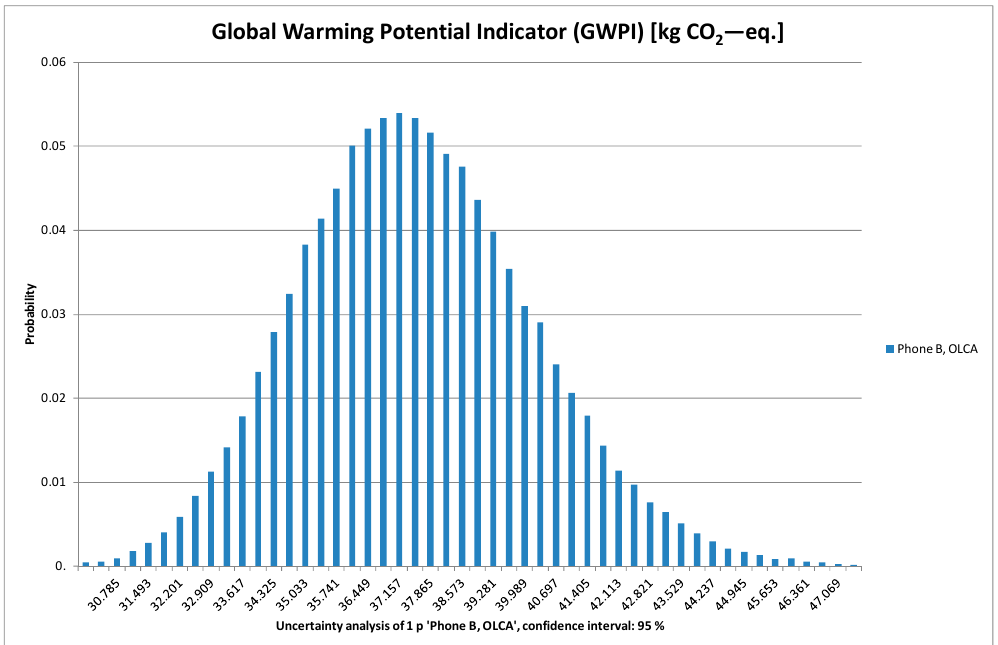
Uncertainty analysis of 1 p 'Phone B, OLCA', confidence interval: 95 %